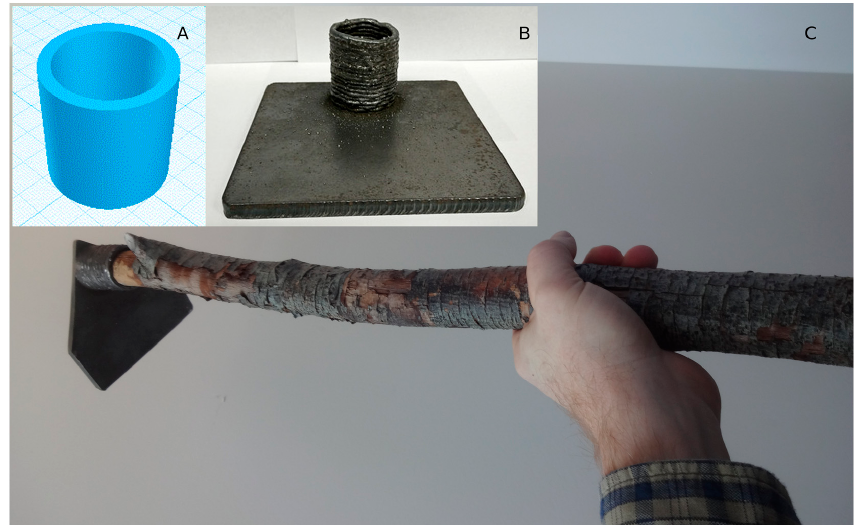
Figure 2. A hoe ( A ) 3-D model of handle hold; ( B ) metal 3-D printed part on substrate; and ( C )